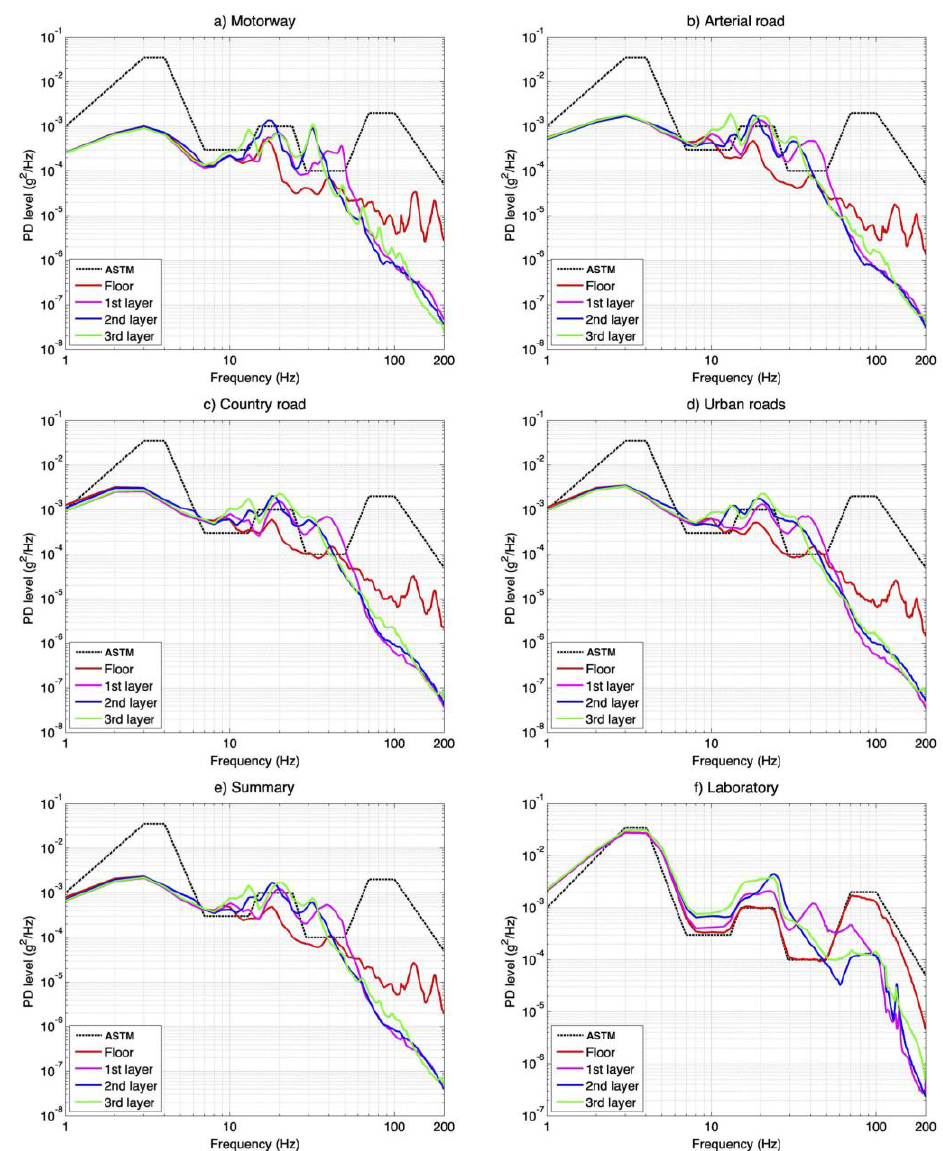
Figure 9. PSD plots of various layers in a stacked unit, on the floor and ASTM D7386 spectrum at, ( a ) Motorway, ( b ) Arterial road, ( c ) Country road, ( d ) Urban roads, ( e ) Summary, ( f ) Laboratory.